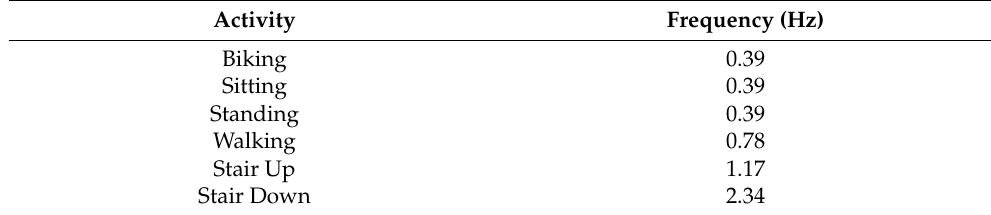
Table 7. Important frequency of each activity in